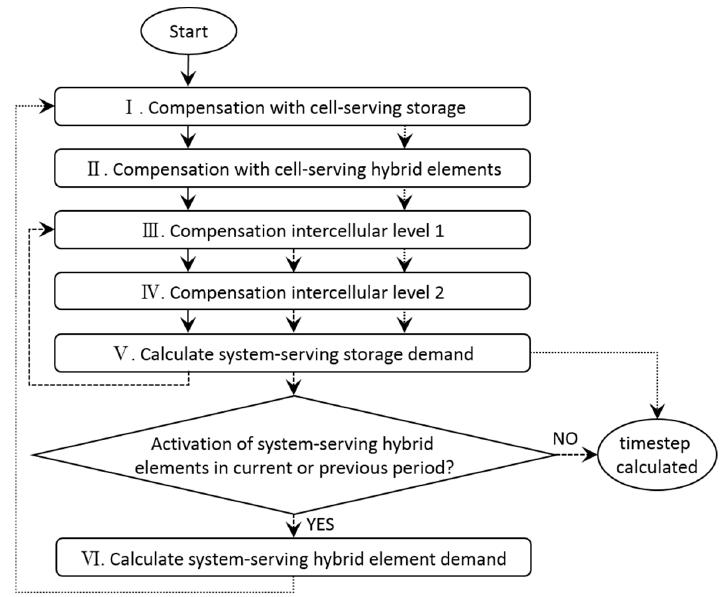
Figure 4. Calculation sequence of the HyFlow modelling framework.